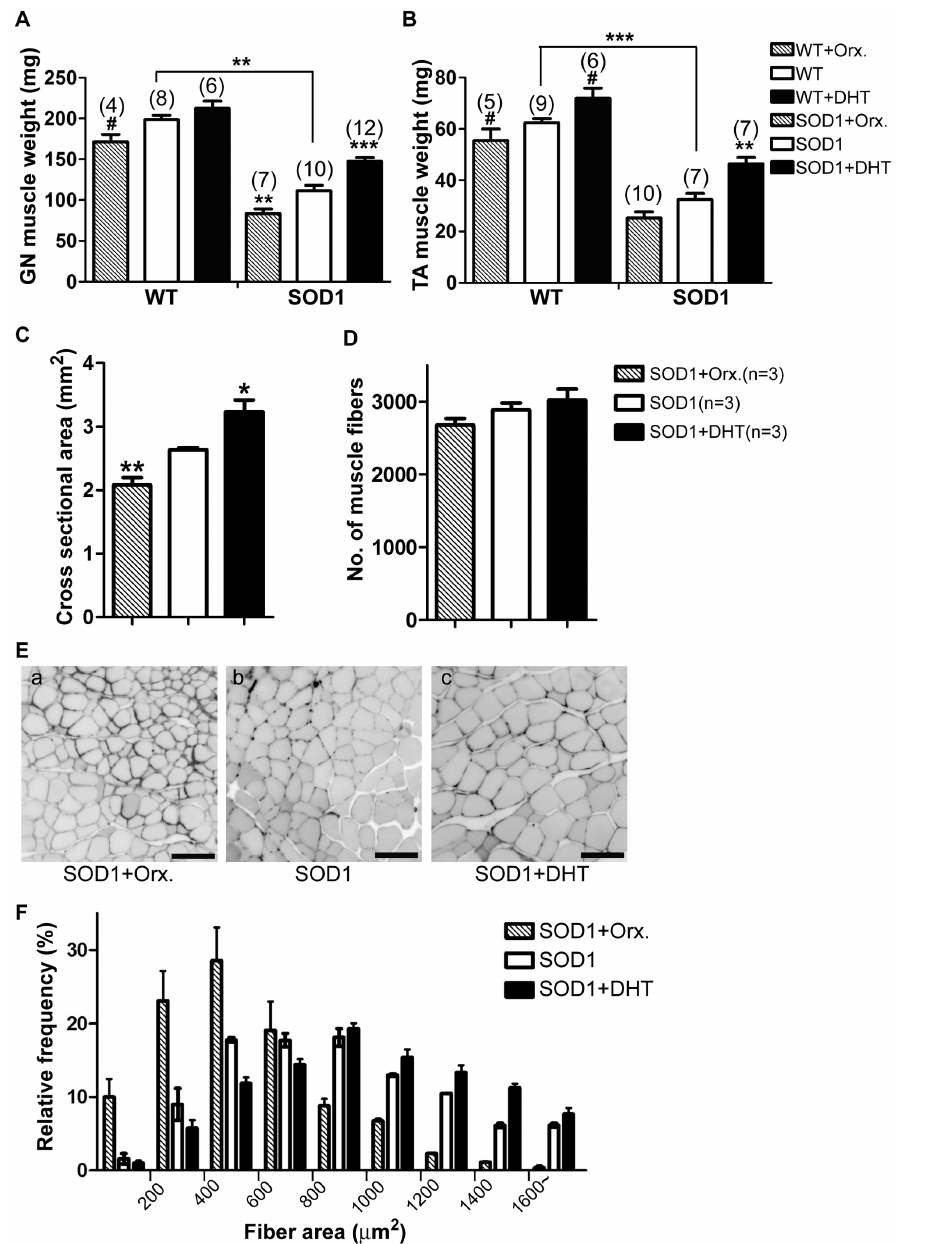
Figure 2. DHT increases whereas orchidectomy decreases the weight and cross sectional area of hindlimb muscles. WT and SOD1 mice were implanted with either a DHT-filled or an empty silastic tube, or orchidectomized at P75, and the morphological analyses were made at P120. A: In WT mice, DHT increased the GN weight by 7% (212.4 6 8.8 mg), whereas orchidectomy decreased it by 14% (171.4 6 9.0 mg) compared with control WT mice (198.4 6 5.5 mg). In SOD1 mice, DHT increased the GN weight by 32% (147.5 6 4.5 mg, p =0.00017), whereas orchidectomy decreased it by 25% (83.4 6 5.7 mg, p =0.0086) compared with control SOD1 mice (111.4 6 6.6 mg). B: In WT mice, DHT increased the weight of TA muscle by 12% (71.2 6 2.5 mg), whereas orchidectomy decreased it by 12% (56.1 6 3.6 mg) compared with control WT mice (63.6 6 1.5 mg). In SOD1 mice, DHT increased the weight of TA muscle by 43% (46.3 6 2.4 mg, p =0.0017), whereas orchidectomy decreased it by 22% (25.2 6 2.4 mg, p =0.05) compared with control SOD1 mice (32.5 6 2.5 mg). Sample size is indicated in ( ) for each group. ## p , 0.01, ### p , 0.01 (compared with age- matched WT mice), ** p , 0.01, *** p , 0.001 (compared with control SOD1 mice). C: DHT increased the cross-sectional area of TA muscle by 22.3% (3.23 6 0.19 mm 2 , n=3, p =0.034), whereas orchidectomy decreased it by 20.8% (2.09 6 0.11 mm 2 , n=3, p =0.008) compared with control SOD1 mice (2.64 6 0.03 mm 2 , n=3). D: DHT did not cause a significant increase in the muscle fiber number (4.8% increase, 3020.7 6 152.2, p =0.49). Likewise, orchidectomy did not cause a significant decrease in the muscle fiber number (7.0% decrease, 2681.0 6 86.9, p =0.19) compared with control SOD1 mice (2883.7 6 97.0). E: Representative pictures of the cross sectional area of TA muscles are shown. Scale bar=50 m m. F: Distribution of the area of single muscle fiber is shown. Per TA muscle, 600–900 muscle fibers were measured, and 3 TA muscles per each treatment group were used for the analysis of muscle fiber area. DHT treatment shifted the area of muscle fibers toward larger areas (1070.8 6 39.8 m m 2 , p =0.032), whereas orchidectomy shifted it toward smaller areas (729.1 6 61.9 m m 2 , p =0.023) compared with control SOD1 mice (904.7 6 26.6 m m 2 ). Data are mean 6 SEM. p , 0.001 (2 way-ANOVA).